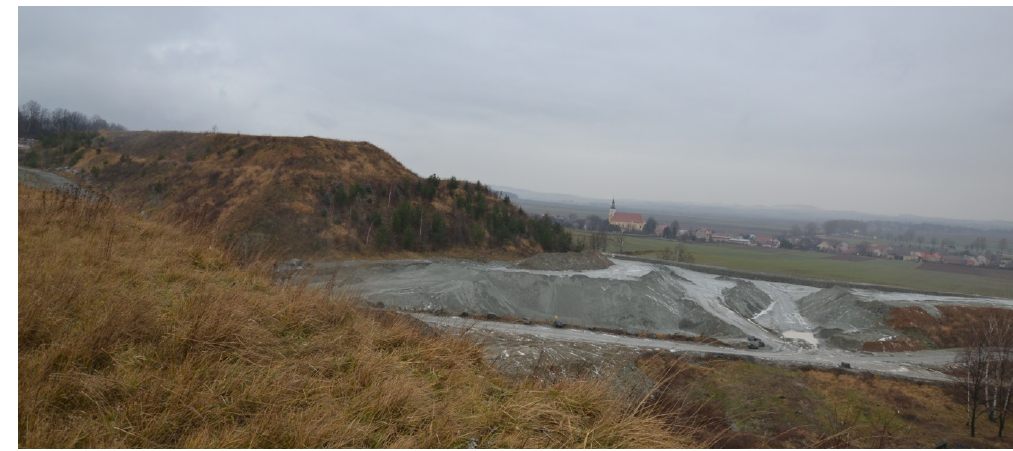
Figure A2. Mining waste treatment facility of the Gabbro Mine “Braszowice” – on the left: completed, on the right: under construction (photo U. Kaźmierczak, 2017).